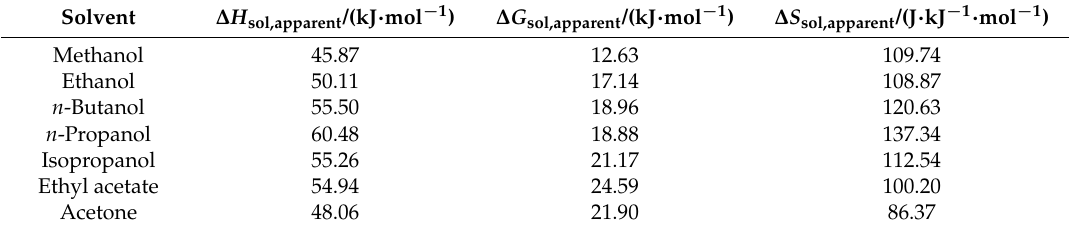
Figure 2. Modified van’t Hoff plot of the mole fraction solubility of metoprolol succinate in selected solvents: ( □ ) methanol; ( ■ ) ethanol; ( ∆ ) n -propanol; ( ▲ ) isopropanol; ( ○ ) n -butanol; ( ● ) ethyl acetate; ( ◊ ) acetone. Table 2. Thermodynamic parameters relative to the solution process of metoprolol succinate in